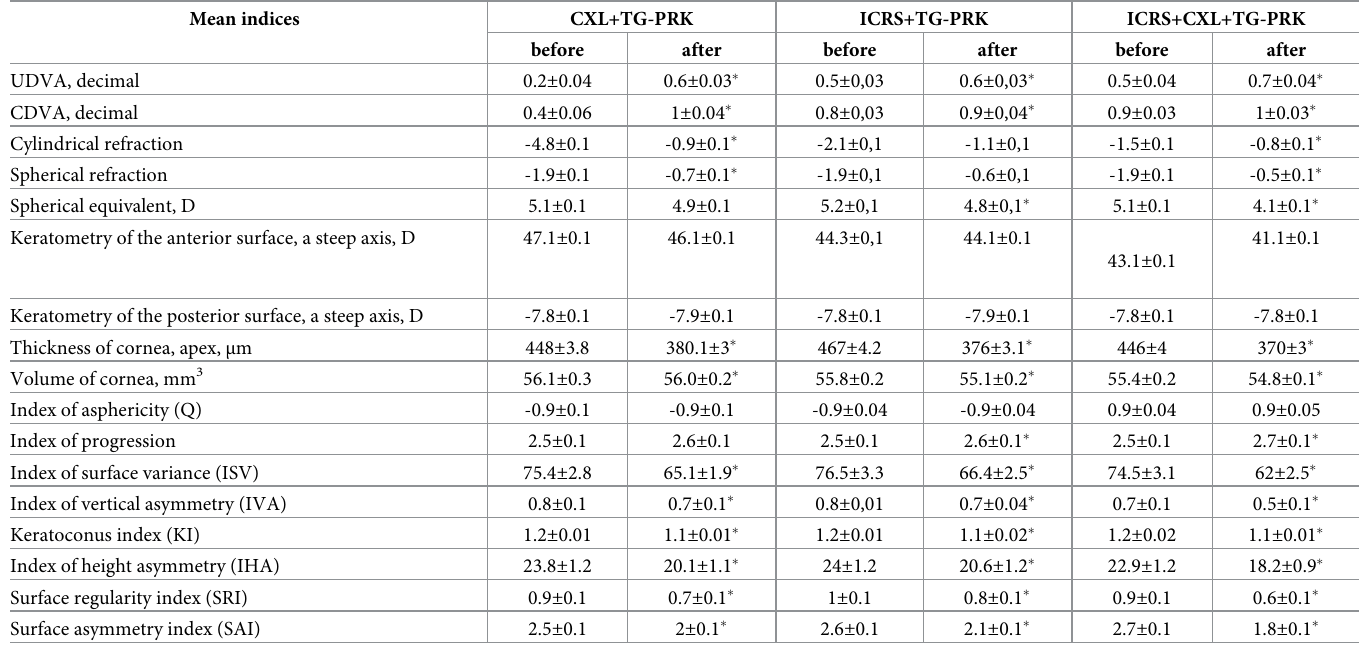
Table 2. Clinical parameters before TG-PRK (8 months after first stage) and 6 months after TG-PRK in patients underwent CXL, ICRS or combined